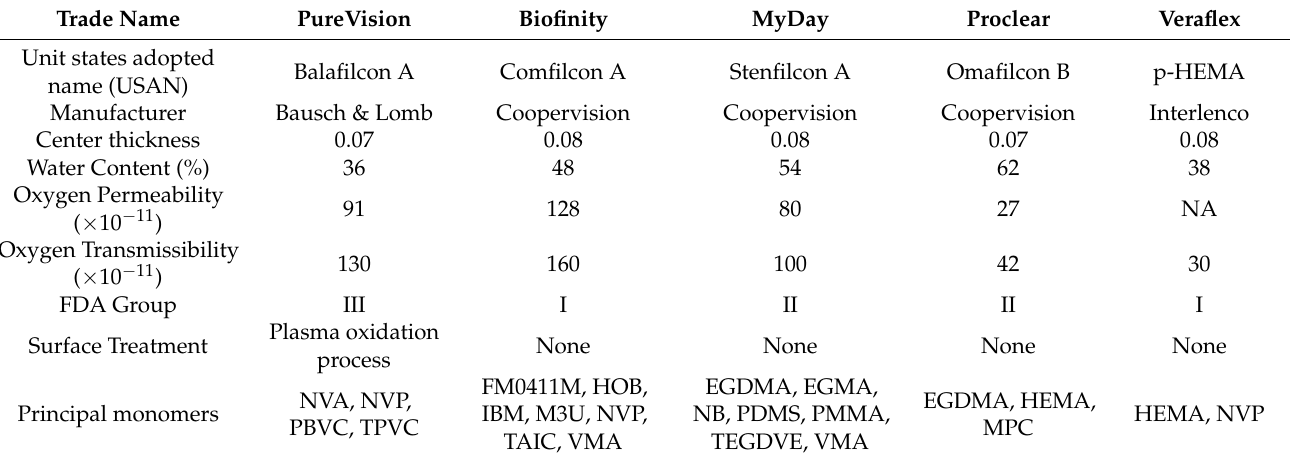
Table 1. The properties of the silicone and conventional hydrogel contact lenses used in the